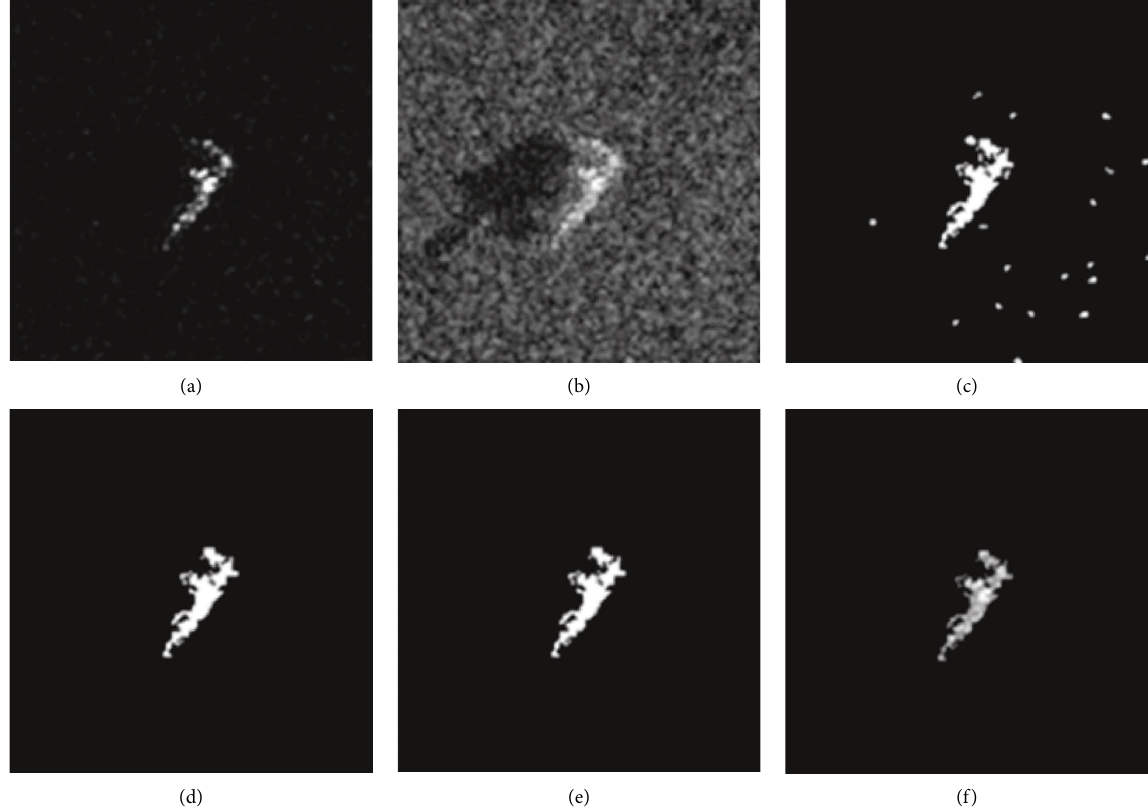
Figure 5: Preprocessed SAR images. (a) Original image; (b) logarithmic image; (c) threshold segmented image; (d) area-based filtered image; (e) distance-based filtered image; (f) image after dot multiplication of (e) and (b).